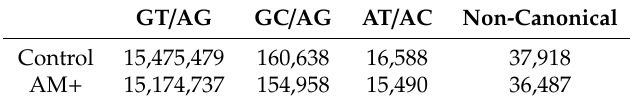
Table 2. Usage frequency of di ff erent splice-sites based on RNAseq reads mapping using STAR.